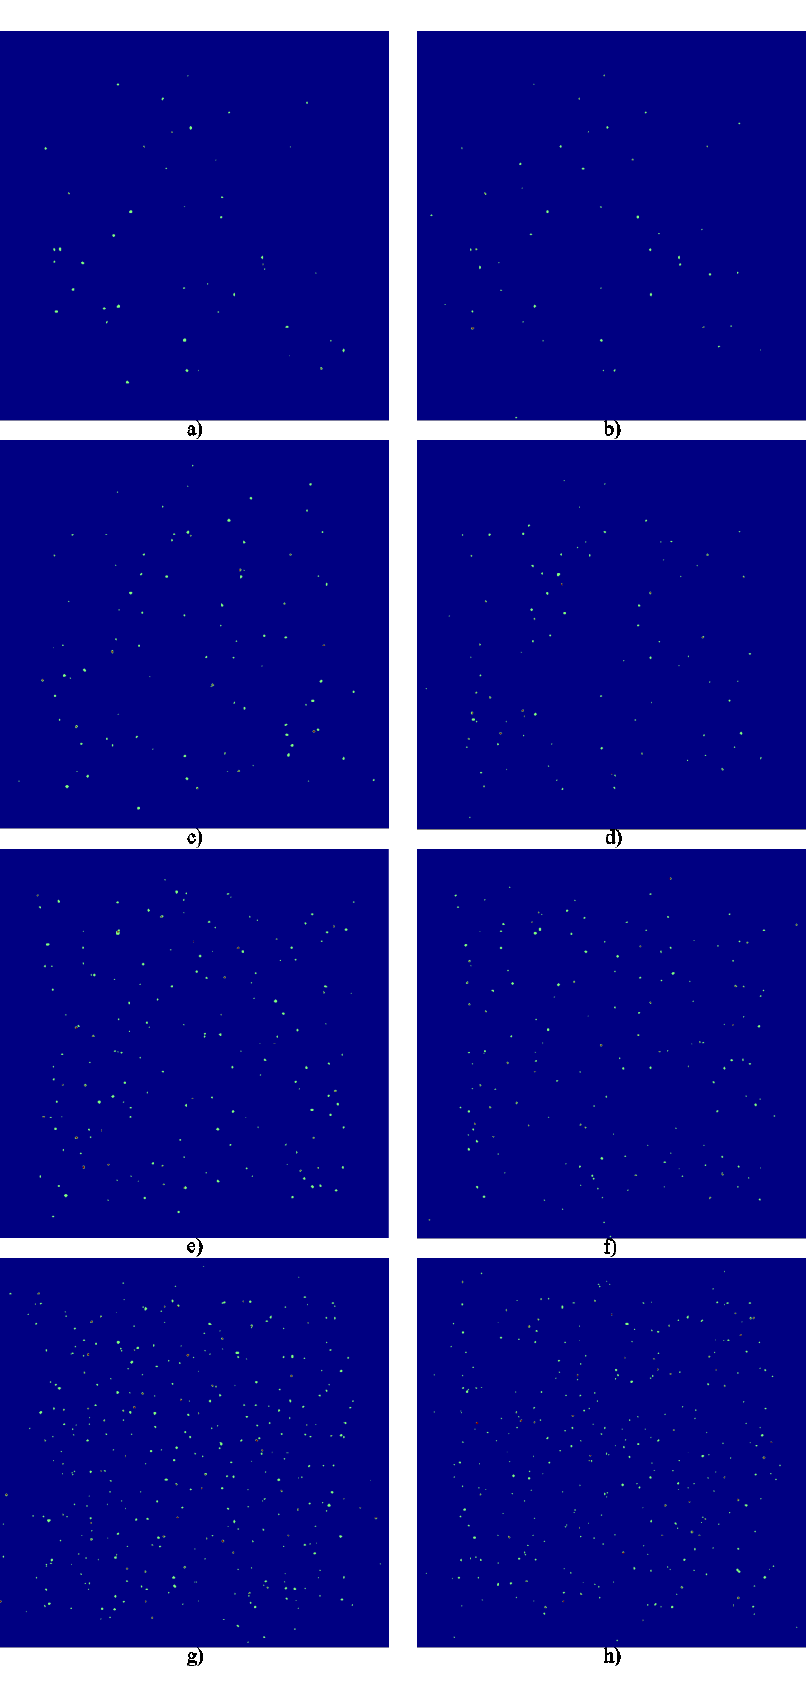
Figure 27. Distribution of collisions on the wall in schemes A050 ( a ), B050 ( b ), A100 ( c ), B100 ( d ), A200 ( e ), B200 ( f ), A500 ( g ) and B500 ( h ).